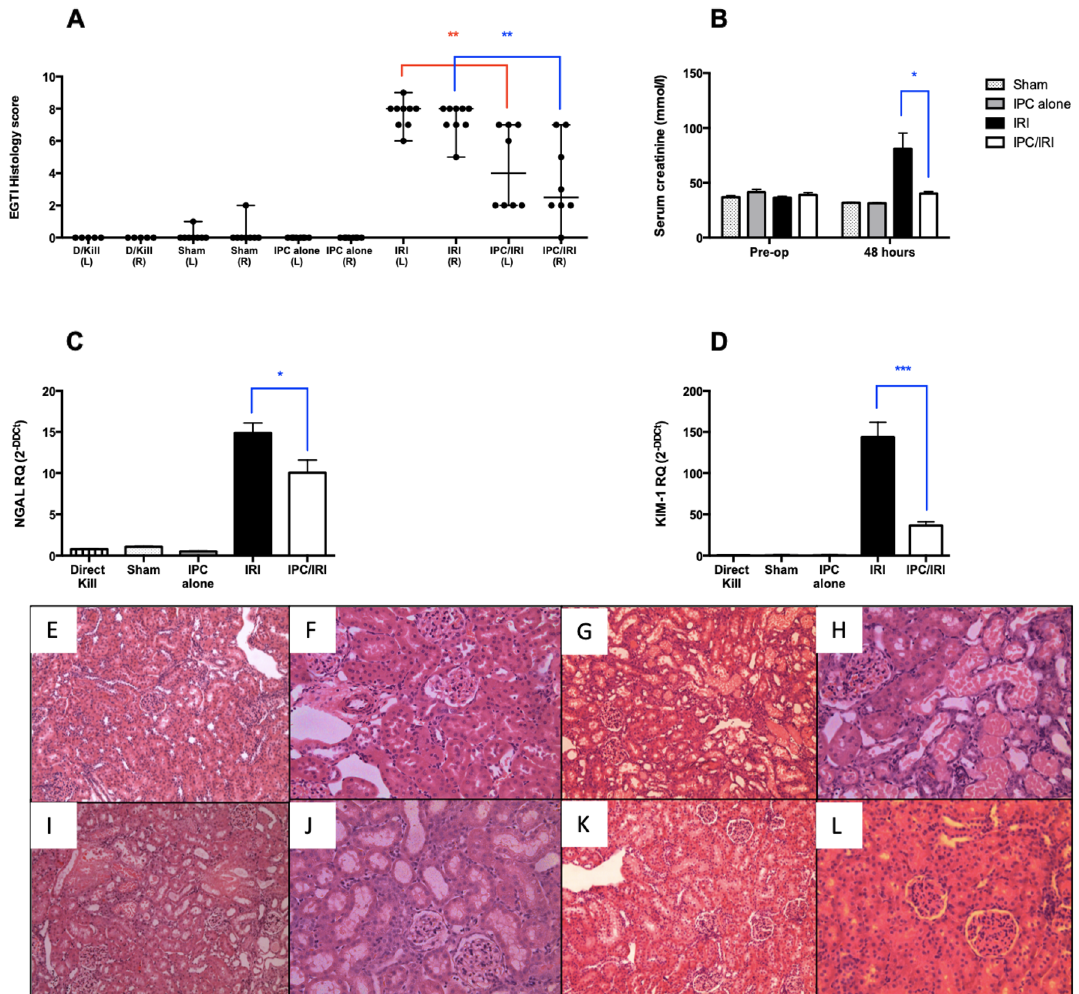
Figure 3. Effect of IPC on EGTI score, serum creatinine and renal injury markers NGAL and KIM-1. (A) Renal cortex sections from Direct Kill, Sham, 45 min bilateral IRI, localized pulsatile IPC (3 cycles of 2 min ischaemia and 5 min reperfusion) prior to IRI, and localized pulsatile IPC (3 cycles of 2 min ischaemia and 5 min reperfusion) alone without any subsequent IRI, in rats at 48 h after reperfusion were stained with H&E and scored for Endothelial, Glomerular, Tubular, and Interstitial cell damage. EGTI Histology scores are plotted as median and range. (B) Serum creatinine was measured pre-op and at 48 h and is plotted as mean ± SEM. (C,D) RT-qPCR analysis of NGAL and KIM-1 was performed following RNA extraction from whole kidney tissue. Expression is normalized to GAPDH and plotted as mean ± SEM. Renal cortex H&E micrographs (× 100 and × 200) show normal appearance in sham (E,F) , moderate to significant damage in IRI (G,H) , mild to moderate damage in IPC/IRI (I,J) and no damage/normal appearance in IPC alone (K,L) groups respectively. Numbers of animals in each group: Direct Kill (n = 5), Sham (n = 8), IRI (n = 9), IPC alone (n = 8), and IPC/IRI (n = 8). Statistical significance: *p < 0.05, **p < 0.01, ***p <